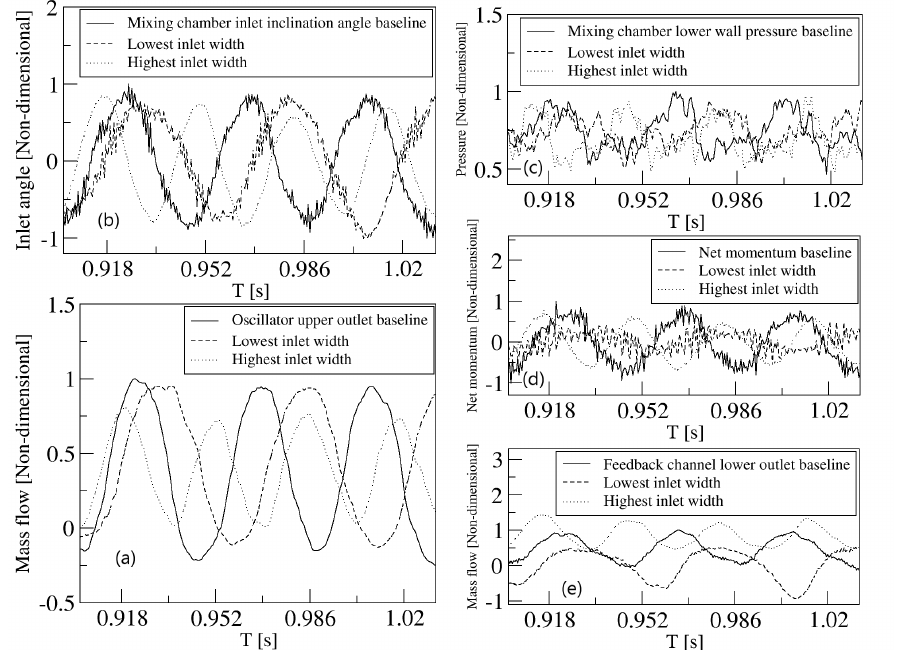
Figure 5. Dynamic effects of the (MC) inlet width modification on the main flow parameters, Reynolds number 16034. Each graph presents three non-dimensional curves characterizing results from the baseline, the lowest inlet width and the highest inlet width cases, and as a function of the dimensional time. In figure ( a ) the mass flow across the upper oscillator outlet is presented. Figure ( b ) introduces the temporal variation of the (MC) inlet inclination angle. Figure ( c ) presents the pressure at the (MC) lower inclined wall. The net momentum acting on the lateral sides of the main jet is presented in figure ( d ). Figure ( e ) characterizes the mass flow at the lower feedback channel